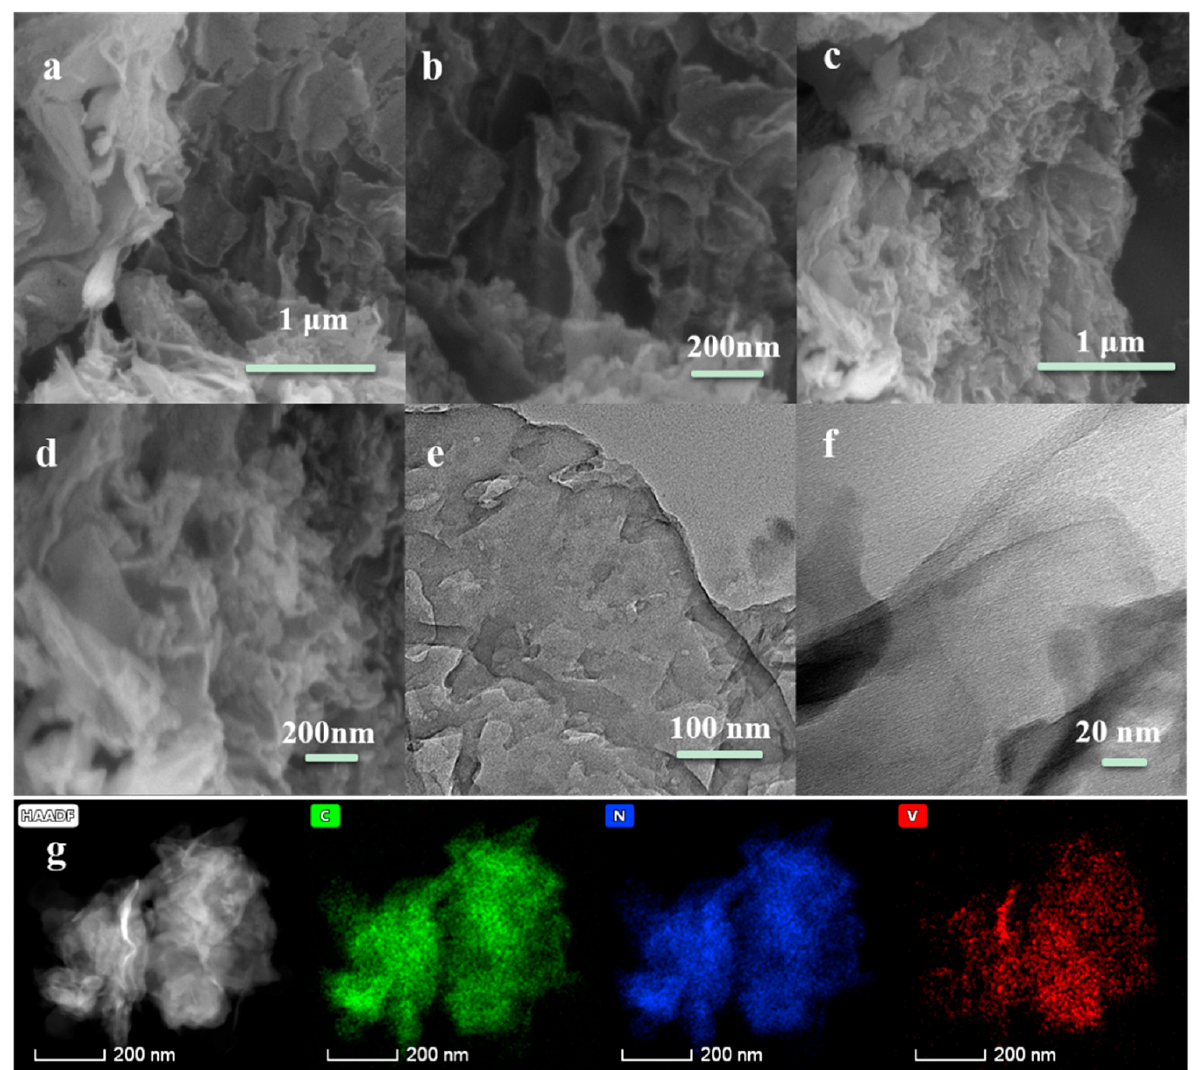
Figure 1. SEM of g ‐ C 3 N 4 ( a , b ) and V ‐ g ‐ C 3 N 4 ‐ 0.5 ( c , d ); TEM ( e ), HR ‐ TEM ( f ) and Elemental mappings Figure 1. SEM of g-C 3 N 4 ( a , b ) and V-g-C 3 N 4 -0.5 ( c , d ); TEM ( e ), HR-TEM ( f ) and Elemental mappings ( g ) of V ‐ g ‐ C 3 N 4 ‐ 0.5. ( g ) of V-g-C 3 N 4